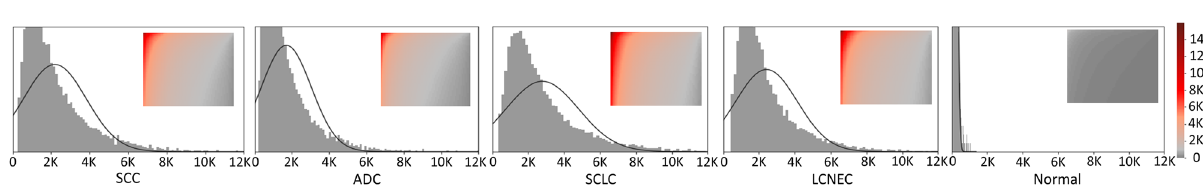
Figure 8. The histograms of pixel values on the averaged HipoMaps of the four subtypes of lung cancer and non-tumor patients, and the averaged HipoMaps (top right corner) on each